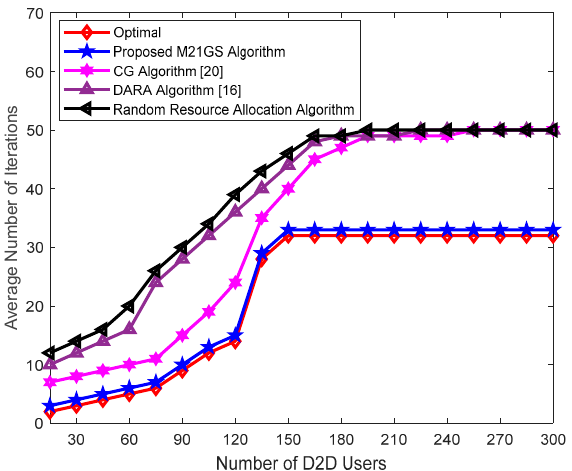
Figure 9. Average number of iterations against the number of D2D users under different algorithms.